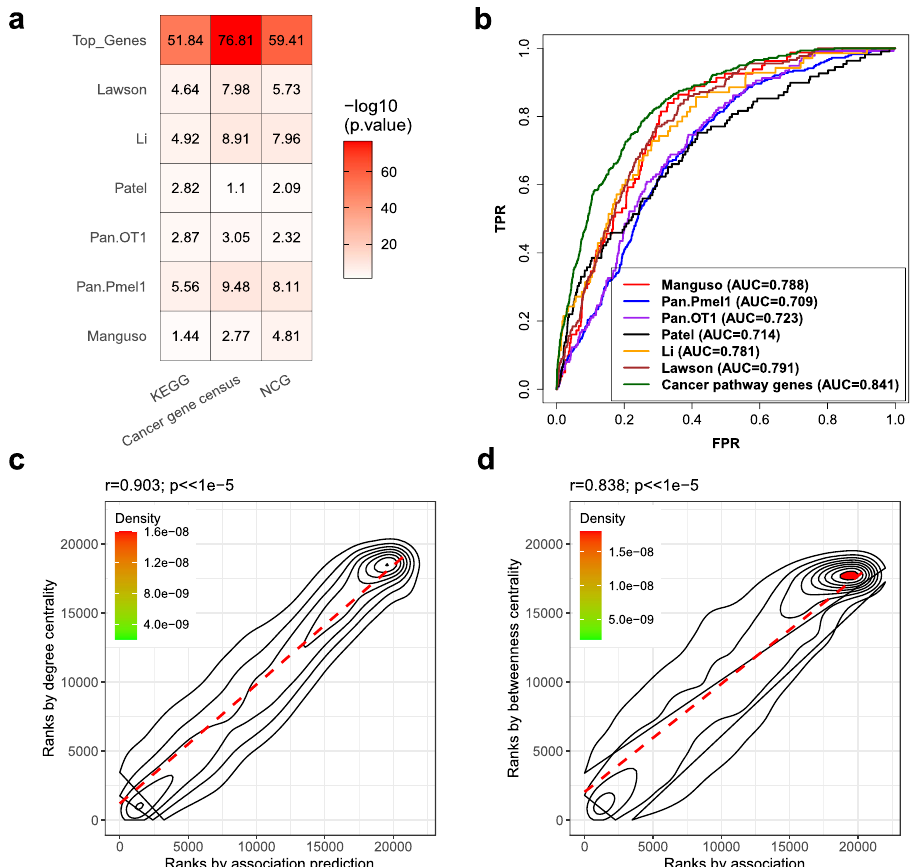
Fig. 3 Some cancer genes acting as network hubs are associated with response to anti-PD-1 therapy. a The overlap analysis of the top 10% of genes in our MHC I-association prediction list (Top_Genes) and all the six CRISPR-based gene sets (same denotations as Fig. 2) with the three cancer gene sets compiled from the databases (see Methods). The color scale in the heat map graph indicates the statistical signi fi cance of the overlap, − log10( p -value), calculated by a one-sided hypergeometric test. b Evaluation of predictions generated by the degree centrality method using the six CRISPR-based gene sets and the KEGG cancer pathway gene set. The gene sets are indicated as in Fig. 2. c Spearman ’ s rank correlation analysis of the prediction generated through MHC I association and the prediction generated using the total degree centrality method. d Spearman ’ s rank correlation analysis of the prediction generated through MHC I association and the prediction generated using the betweenness centrality method. Correlation. The correlation coef fi cient and p -value of the analysis is shown in the upper corner of each correlation plot. The source data of all the panels in this fi gure are provided in the Source Data fi